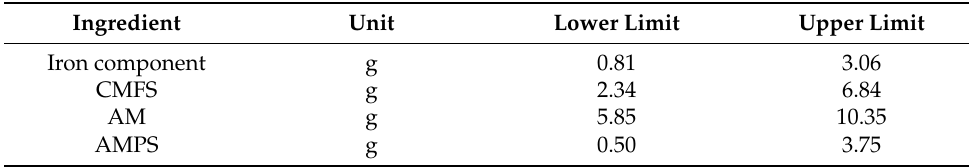
Table 1. Component quality level of each factor.